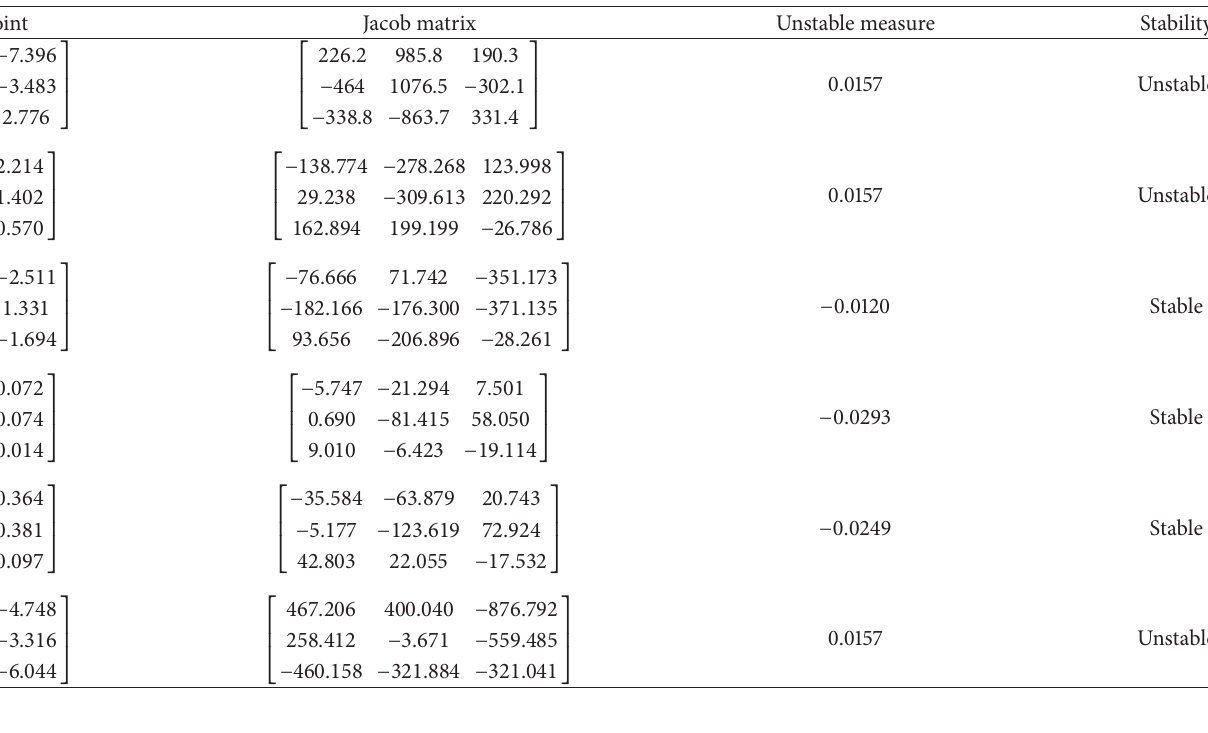
Table 4: Results about stability analysis of economic system about UK.